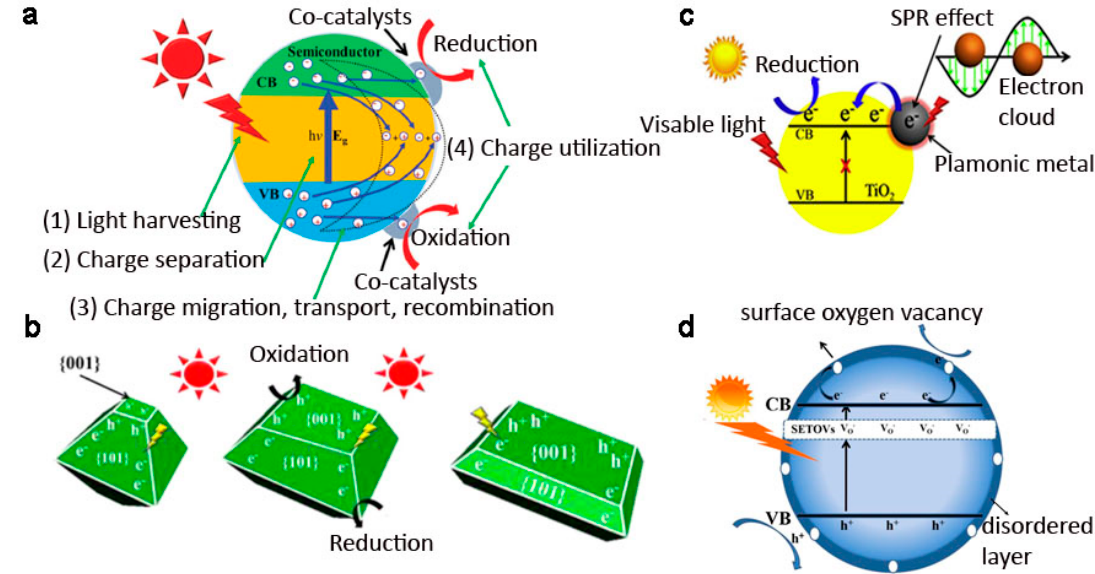
Figure 5. ( a ) Different stages in heterogeneous photocatalysis (Reproduced with permission from [63], Copyright The Royal Society of Chemistry, 2016); surface/interface engineered TiO 2 structures for photocatalytic improvement: ( b ) crystallographic plane tuning (Reproduced with permission from [64], Copyright American Chemical Society, 2014), ( c ) defects engineering (Reproduced with permission from [65], Copyright Elsevier B.V., 2016), and ( d ) creating interfaces in TiO 2